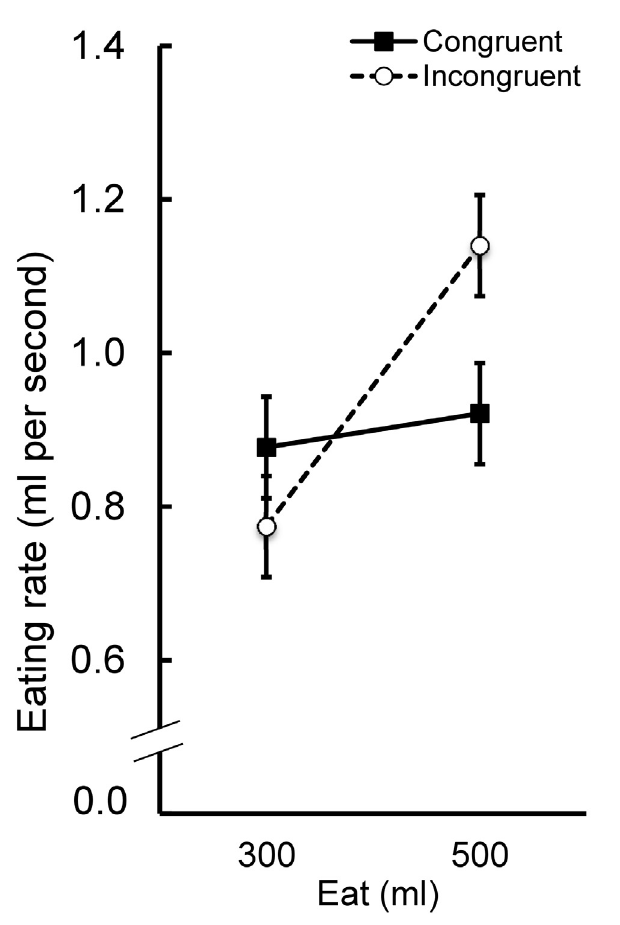
Fig 2. Mean ( ± S . E .) eating rate (ml / second) for participants in each